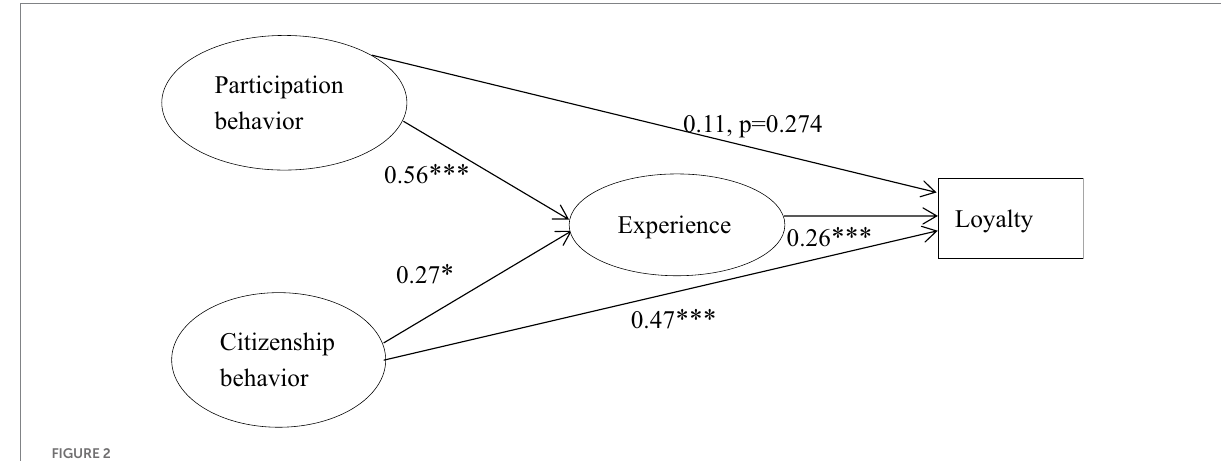
FIGURE 2 Structural model of customers’ experiences with P2P